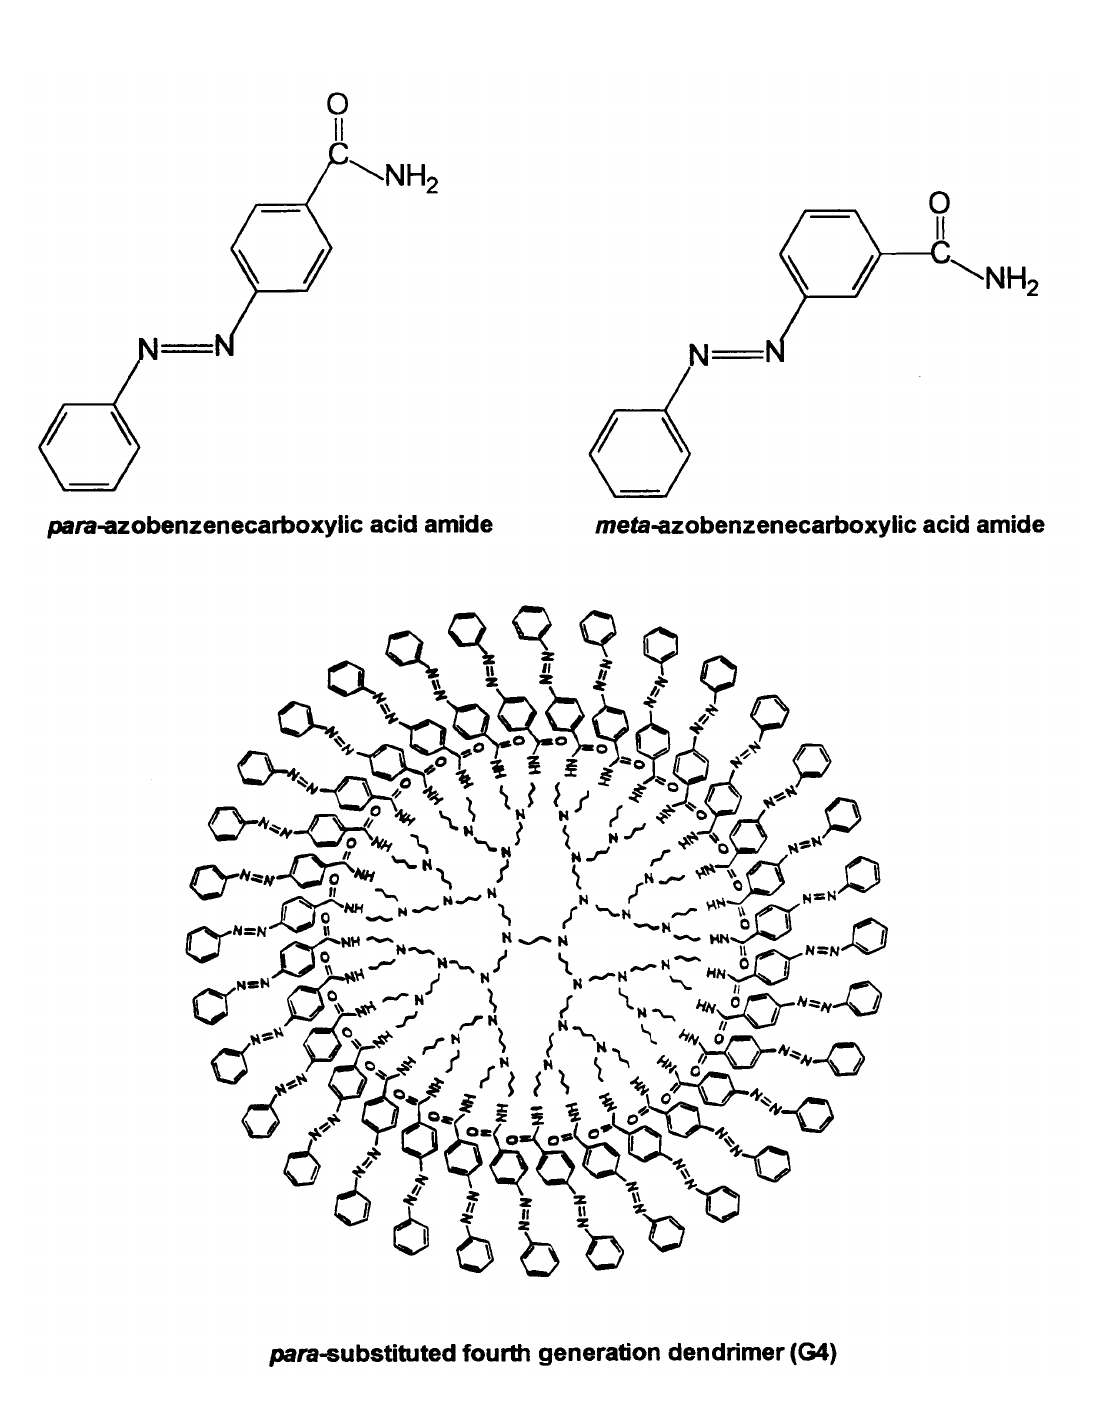
Fig. 2 – Structures of the monomeric model compounds and the G4 p-azobenzene substituted dendrimer.